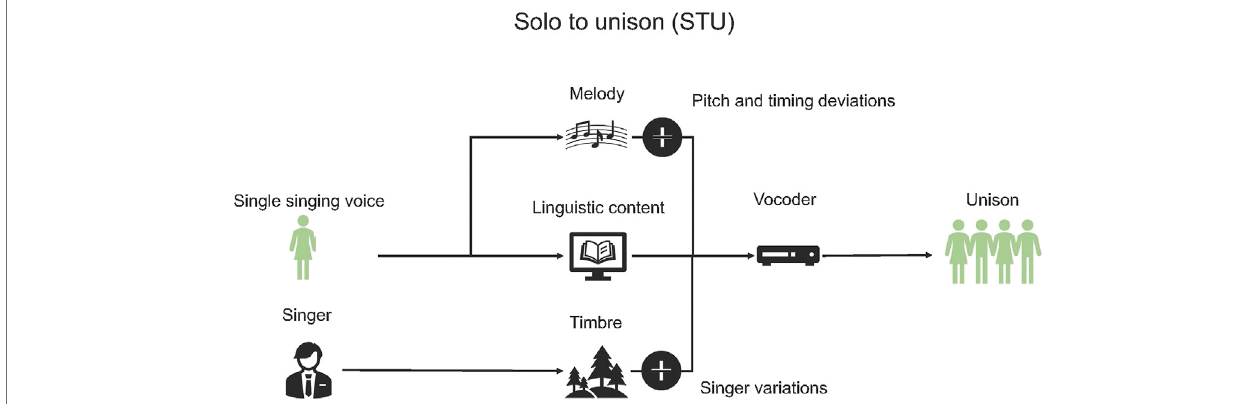
FIGURE 1 | Diagram of the Unison-to-Solo (UTS) methodology.